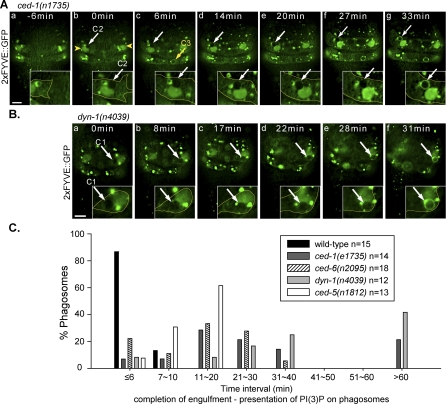
The Appearance of PI(3)P on Phagosomal Surfaces Is Significantly Delayed in ced-1, dyn-1, and ced-6, but Not ced-5, Mutants(A and B) Time-lapse recordings of a ced-1(e1735) (A) and a dyn-1(n4039) (B) embryo, expressing Pced-1 2xFYVE::gfp. Anterior is to the top. Ventral faces readers. Arrows indicate phagosomes. Arrowheads indicate the nuclei of migrating hypodermal cells. Scale bars indicate 5 μm. “0 min” represents the first time point when engulfment is complete. The inset inside each panel is a 2-fold enlargement of the region around the white arrow, with the shape of the engulfing cell highlighted. In both (A) and (B), the appearance of PI(3)P on phagosome surface is delayed.(C) Histogram distribution of the PI(3)P presentation time in different backgrounds. The time is defined as the interval between the completion of engulfment and the first appearance of PI(3)P on phagosomal surfaces. Data are collected through time-lapse recording of the C1, C2, and C3 phagosomes. n, number of phagosomes scored.